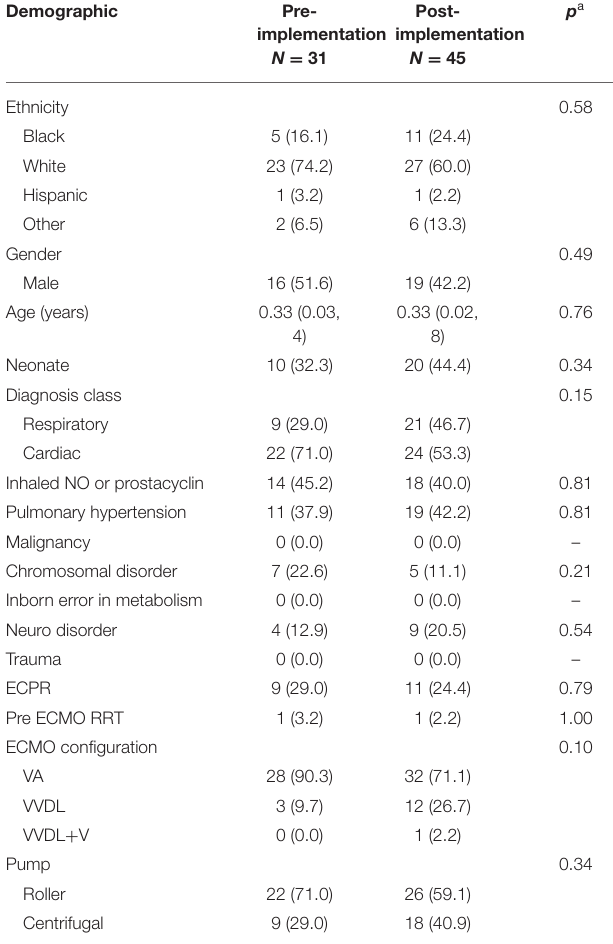
TABLE 2 | Patient characteristics prior to ECMO